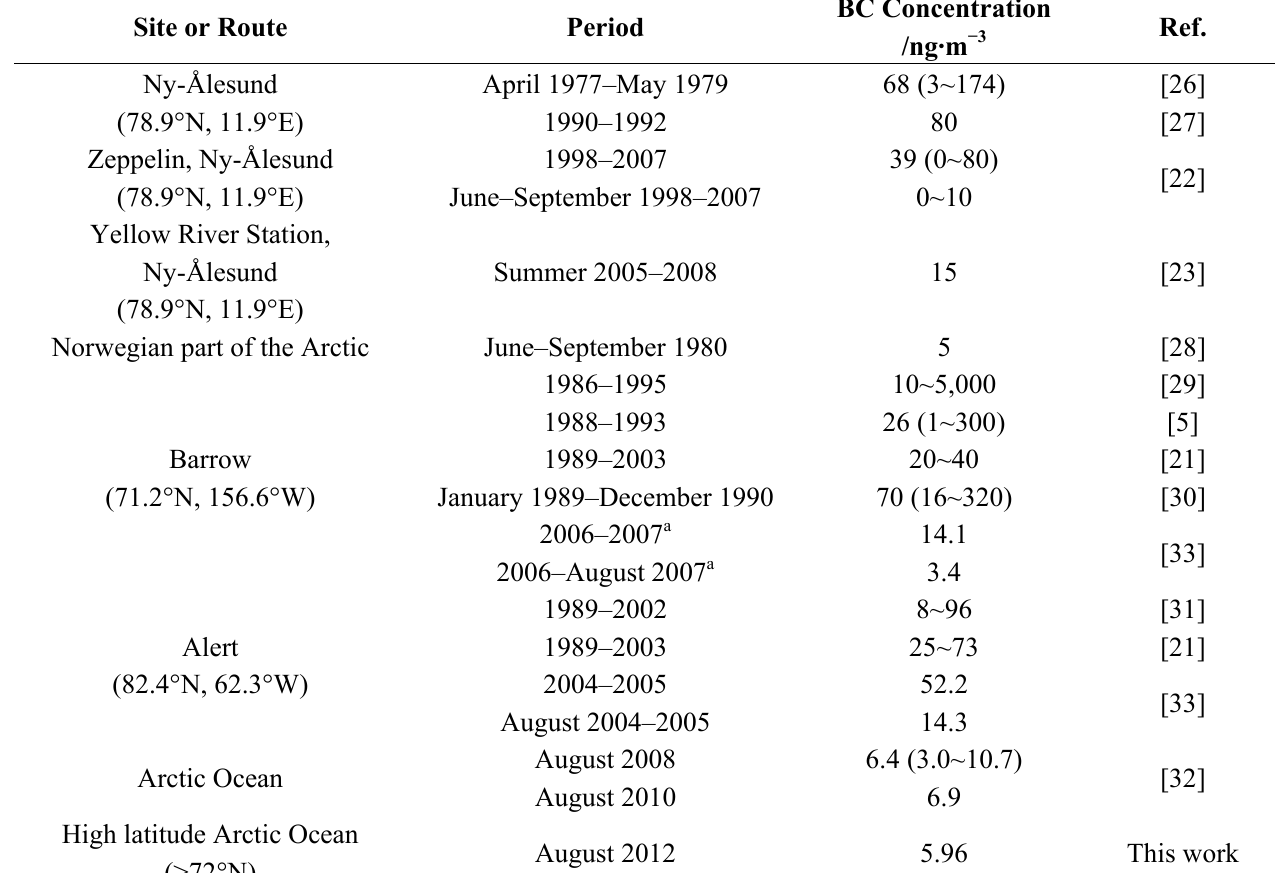
Table 2. Black carbon concentrations at Arctic land sites and the Arctic